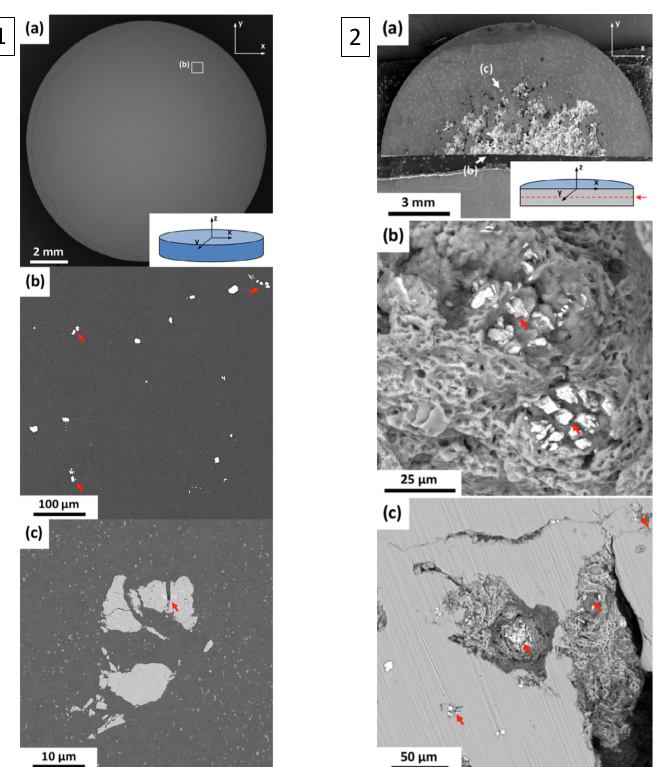
Figure 5. SEM micrographs of the as-received AZ31B-4E Mg alloy sample in backscattered electron contrast (BSE) mode, where: 1( a ) investigated sample, 1( b ) zoomed-in view secondary phases of Al-Mn, and 1( c ) high-magnification of the sample showing a cluster of broken secondary phases of large Al-Mn intermetallic inclusions surrounded by a smaller distribution of the same phase. SEM micrographs (BSE mode) of the mid-plane (spall plane) of the recovered AZ31B-4E Mg alloy sample shock compressed to approximately 1.7 GPa: 2( a ) investigated specimen (the red arrow indicates the position of the plane of the specimen under investigation), 2( b ) zoomed-in fracture surface at the center of the spall plane with intermetallic inclusions identified by arrows, and 2( c ) zoomed-in fracture surface at the edge of the spall plane with intermetallic inclusions [13].